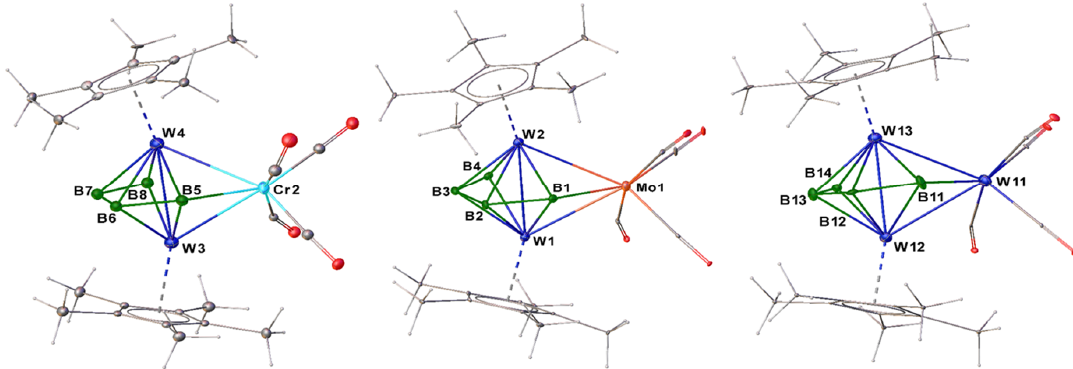
Figure 1. Molecular structures and labeling diagrams of 1 , 2 and 3 . Bridging hydride ligands and hydrogen atoms attached to the boron atoms could not be located. Selected bond lengths (Å) and